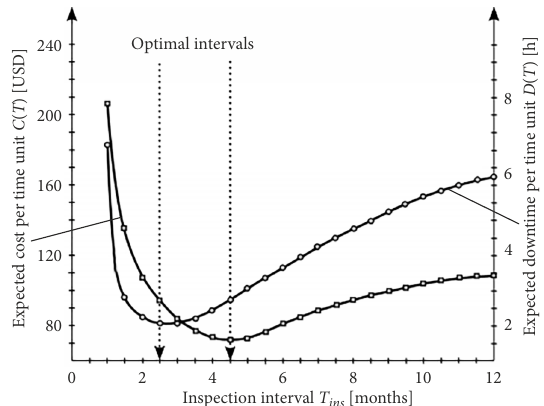
Optimal intervals